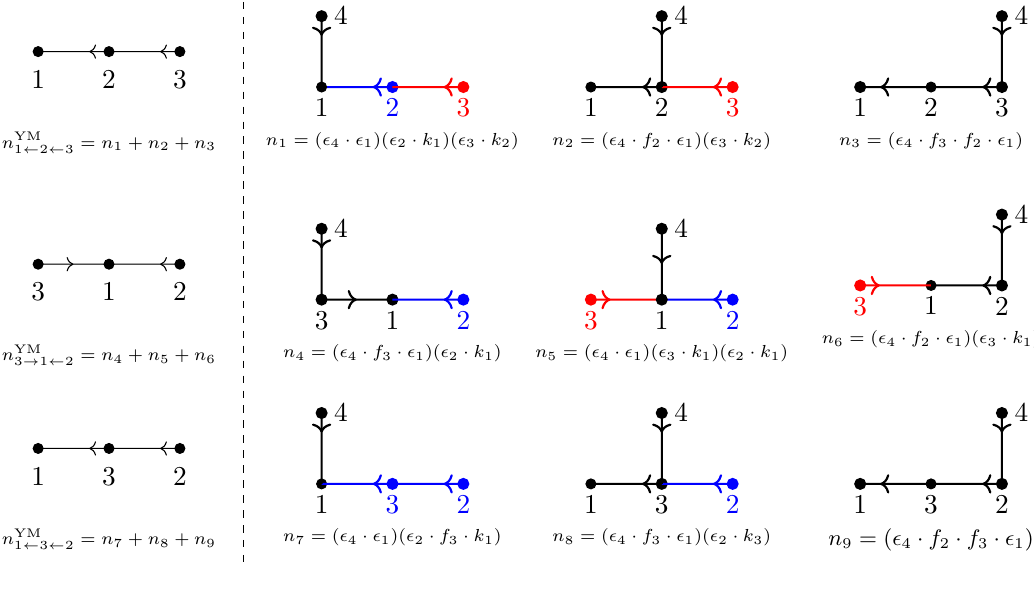
Figure 1 . Cayley numerators of Pf 0 Ψ 4